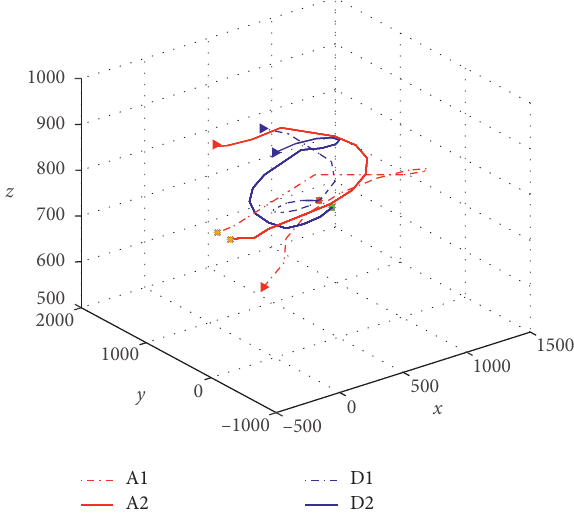
Figure 6: Multi-UUV cooperative dynamic maneuver decision-making: stage 3.